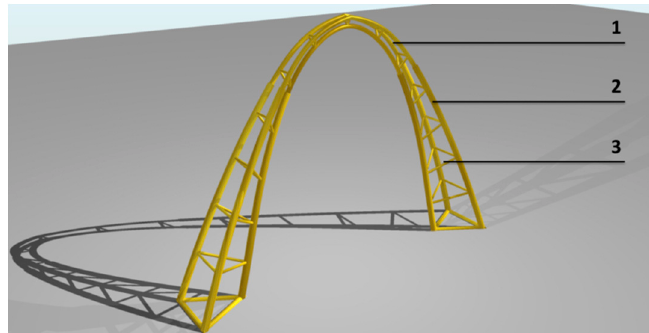
Figure 4. Perspective of date palm midribs tri-arched space truss (Reproduced from [8]). (1) The middle midribs bundle is thinner to form the parabolic shape. (2) The bottom midribs bundles are thicker to take thrust. (3) Bracings.